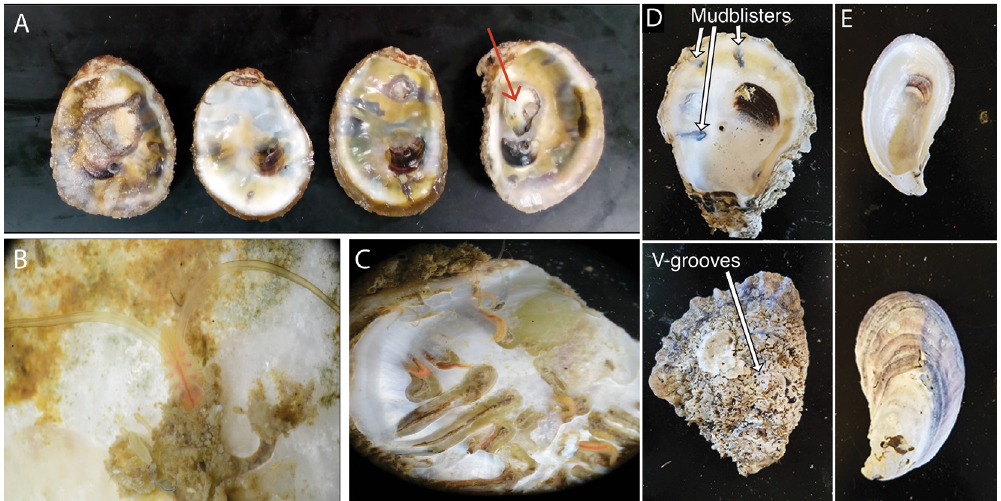
Fig. 1. (A) Oyster shells with a high prevalence of mudblisters. Arrow on the far-right shell shows a popped mudblister; (B) head of Polydora websteri with palps extended protruding from mud burrow inside of oyster shell; (C) inside of broken oyster shell show- ing U-shaped burrows of P. websteri lined with detritus and mud; (D) previously infested oyster shell with presence of mudblisters and abundance of V-shaped grooves; (E) previously uninfested oyster shell with no mudblisters and few V-shaped